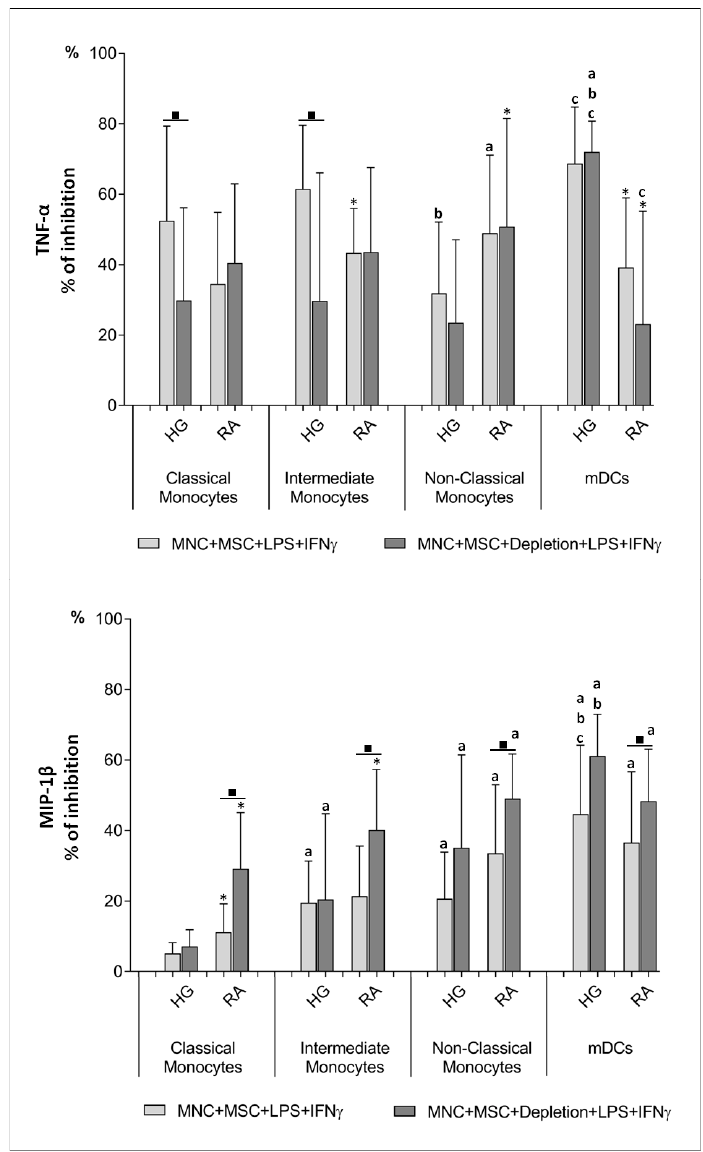
Figure 5. Percentage of BM-MSC-derived inhibition of TNF- α and MIP-1 β protein production, by monocytes and mDCs, from RA patients and healthy individuals. Percentage of the inhibition (mean ± standard deviation), mediated by BM-MSCs, on the percentage of TNF- α - and MIP-1 β -producing monocytes and mDCs, evaluated either when BM-MSCs were in the cell culture during PBMCs’ activation with LPS and IFN γ , or when BM-MSCs were removed from the cell culture immediately